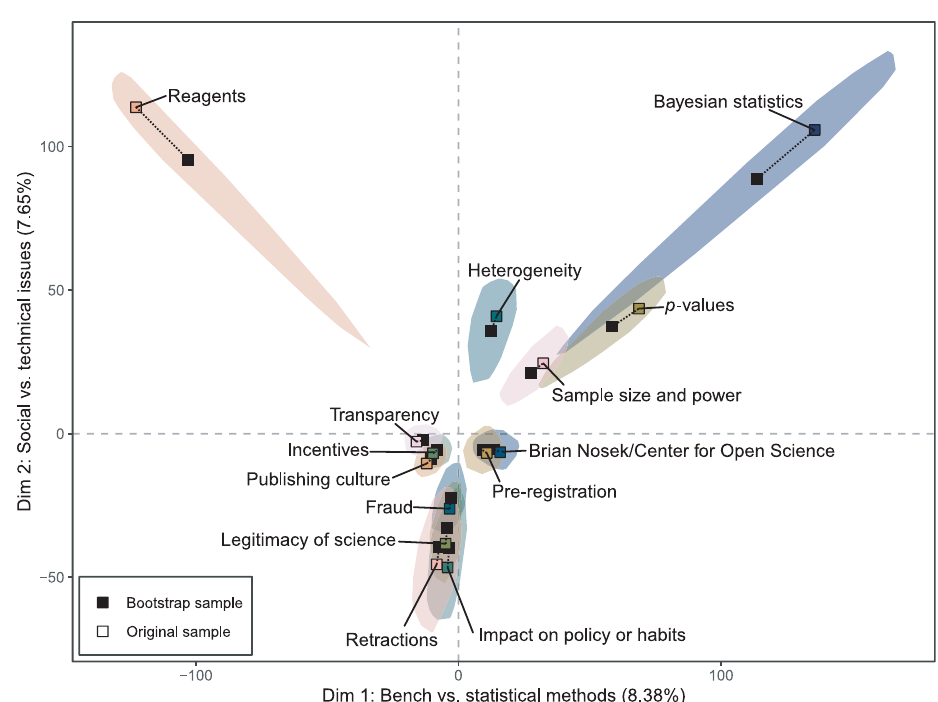
Fig 5. Multiple factor analysis of bootstrap samples drawn a set of 353 articles on reproducibility. Shaded areas indicate the peeled convex hulls of points based on 1000 bootstrap replicates plus the original sample, showing an approximate 95% confidence region for each theme. Twenty-nine codes were included in the analysis, but only select codes are displayed for legibility. Colored squares indicate the position of each theme based on the original sample, and black squares indicate the position of each theme based on the overall bootstrap